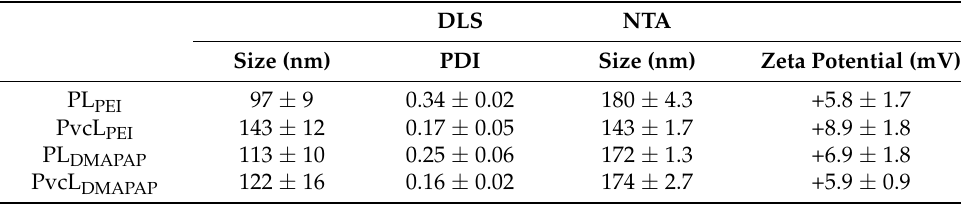
Table 3. DLS and nanoparticle tracking analysis (NTA) analyses for the PL PEI , PvcL PEI , PL DMAPAP , and PvcL DMAPAP formulations. The size is represented by the mean hydrodynamic average diameter by intensity and the polydispersity index (PDI). The values and standard deviation are given for nine values, triplicates measured three times each ( n =